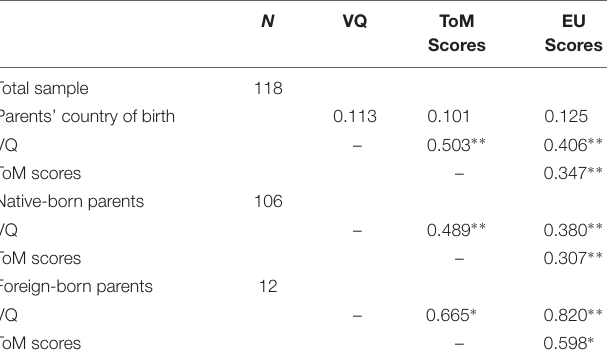
TABLE 5 | Correlations among parents’ country of birth, language ability (VQ), ToM Storybooks and TEC scores, after controlling for age. N VQ ToM